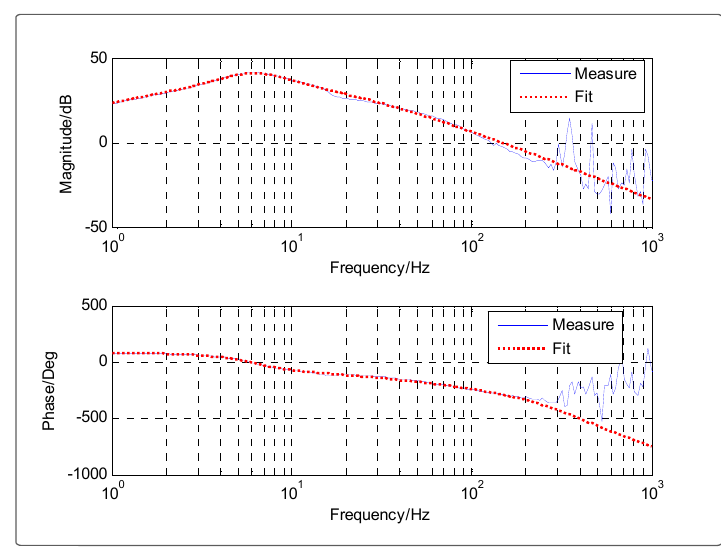
Figure 10. The open-loop bode response of the velocity.